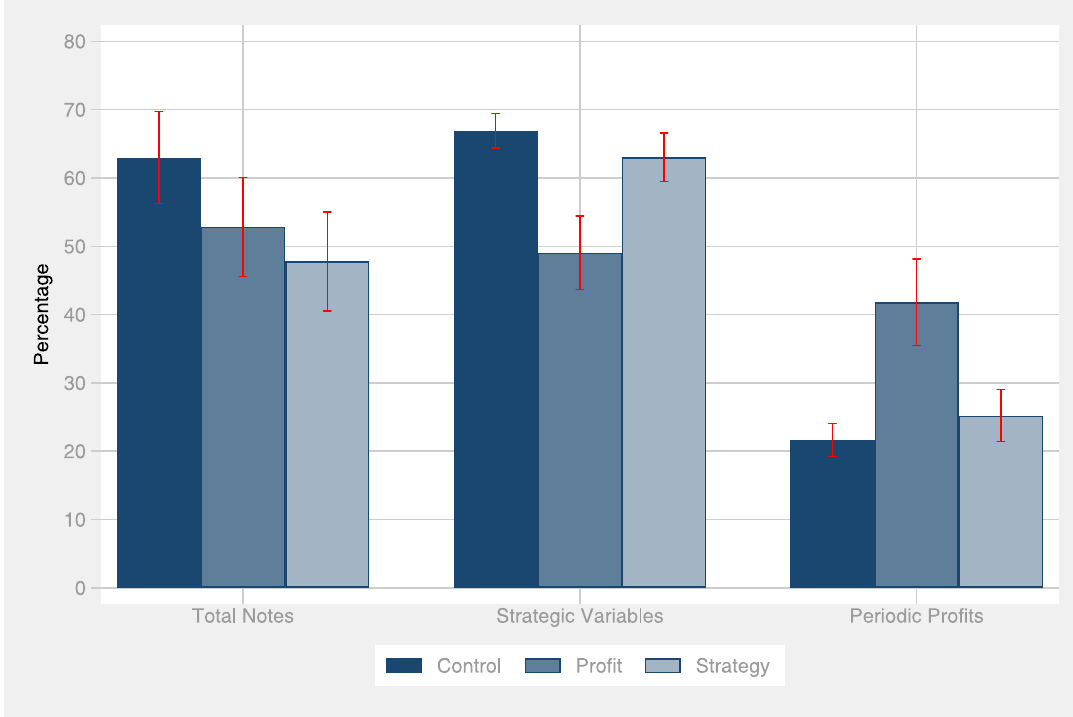
Fig 3. Note-taking behavior. For each experimental group, the figure reports the percentage of total notes taken as well as the means of participants? notes taken, in regards to the strategic decision variables, the periodic profits and the obtained feedback (relative to the total notes taken). Error bars indicate standard errors of the